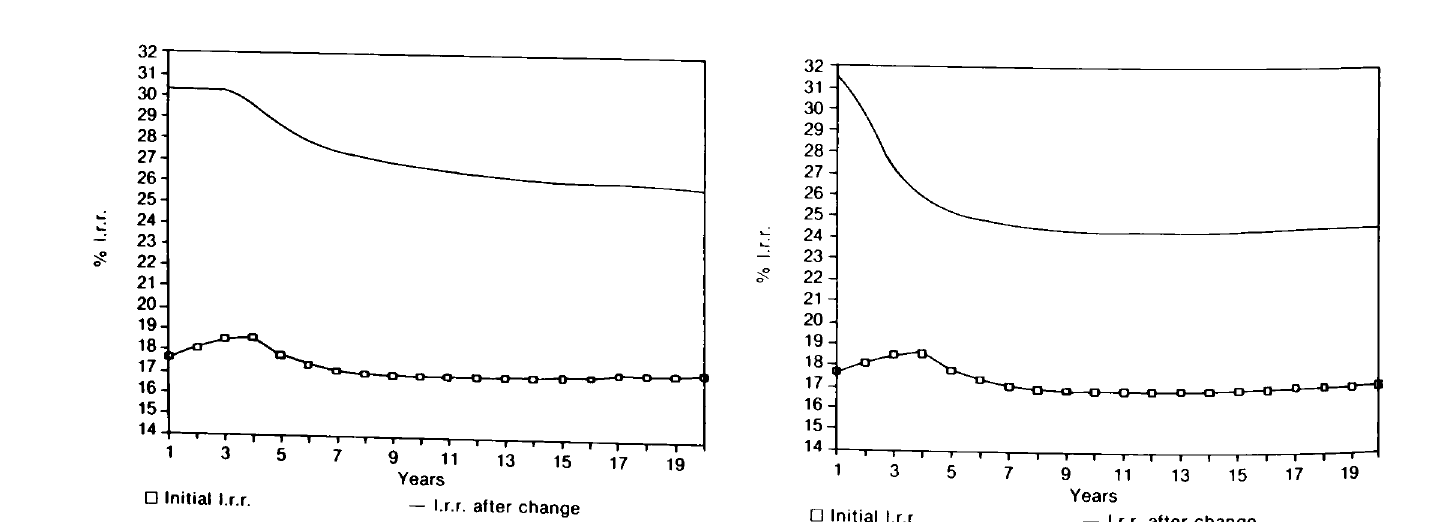
Figure 3 The effect of implementing the profitability rate on an after tax basis on the internal rate of return (i.r.r.) of company